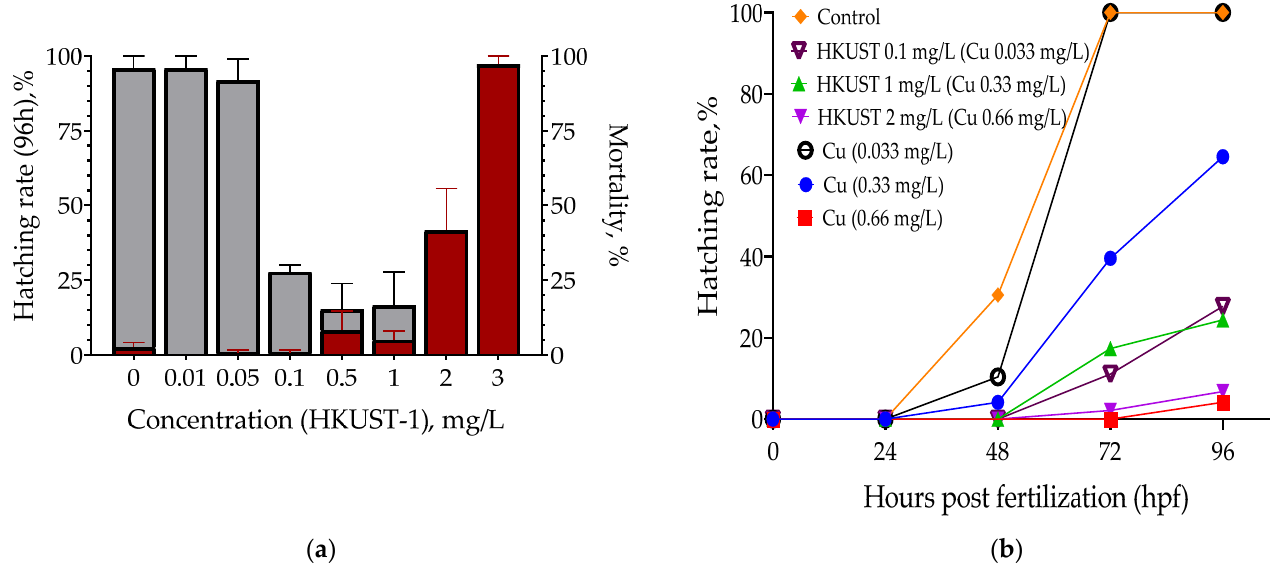
Figure 2. Mortality of D. rerio embryos ( a ) and hatching rate ( a , b ) for HKUST-1 (Cu-MOF) NPs and Cu 2+ ions 0–96 h exposure.